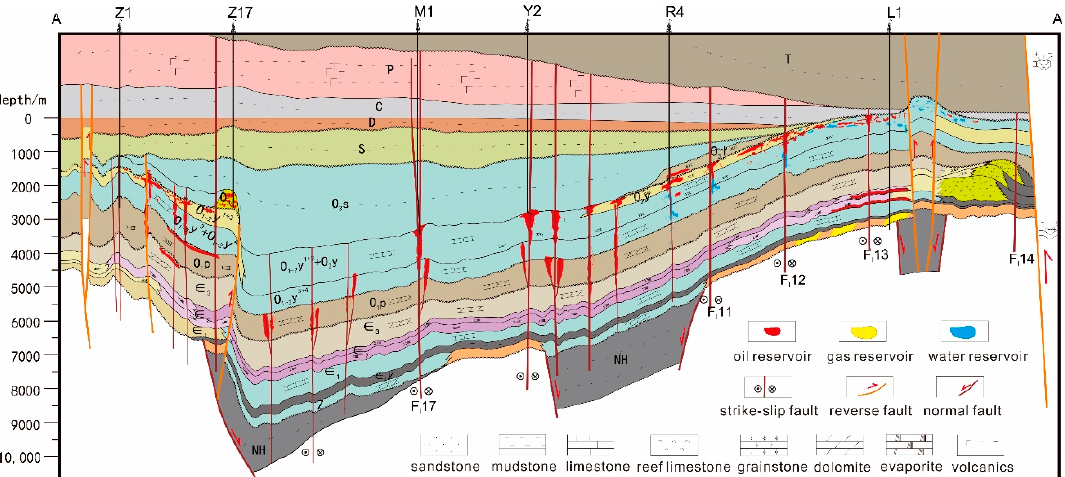
Figure 2. Reservoir model of the strike-slip fault-controlled petroleum system in the Tarim Basin (flattened from the base of the Carboniferous period; NH: Cryogenian; Z: Sinian; ∈ 1 : Yuertusi Formation; O 1 p: Penglaiba Formation; O 1-2 : Yingshan Formation; O 2 y: Yijianfang Formation; O 3 l: Late Ordovician Lianglitage Formation; O 3 s: Late Ordovician Sangtamu Formation; S: Silurian; C: Carboniferous; P: Permian; T: Triassic).